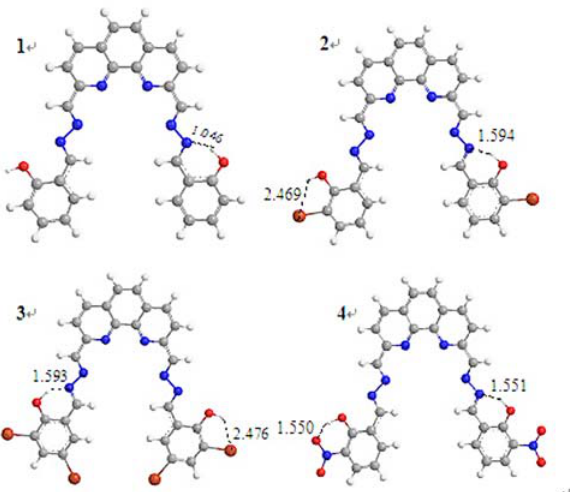
Fig. 8. Optimized structures of four compounds